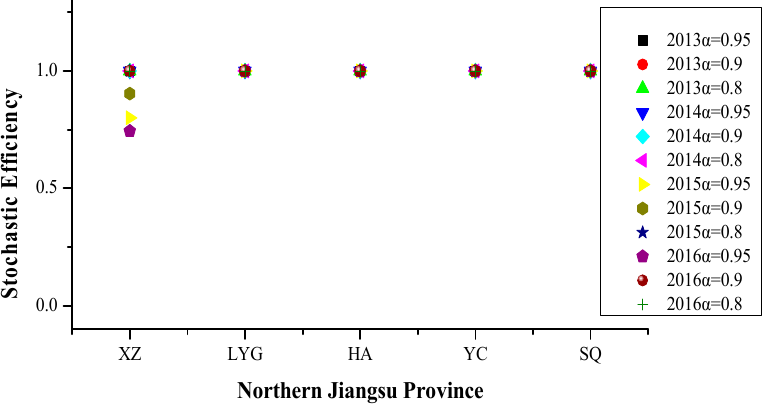
Figure 8. Stochastic e ffi ciency values in northern Jiangsu province at di ff erent risk levels in